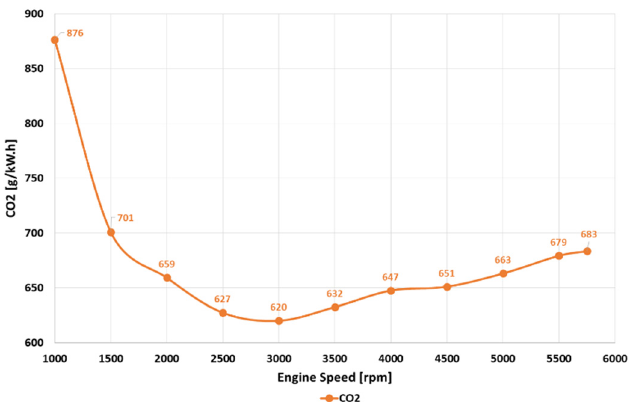
Figure 14. ( a ) HC and ( b ) NO predicted emissions.